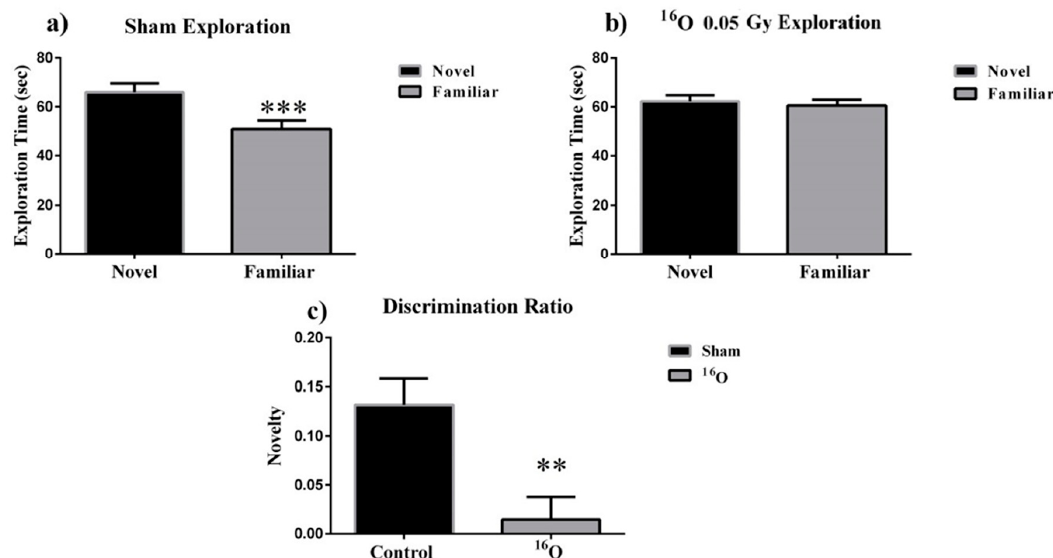
Figure 2. Novel object recognition. ( a ) sham-irradiated animals spent significantly more time exploring the novel object. ( b ) Irradiated groups were unable to discern the novel from the familiar object on test day, whereas ( c ) radiation induced decreased discrimination ratios, representing an inability to discriminate between the novel and familiar objects. Average ± SEM ( n = 12); ** p < 0.01, *** p < 0.001.